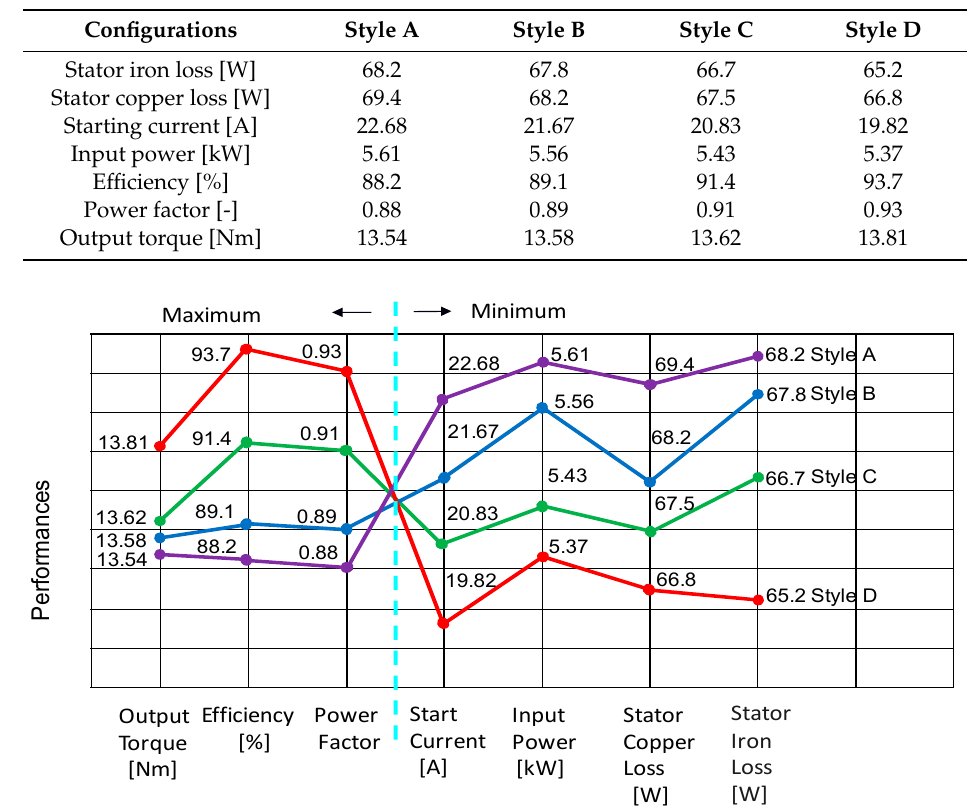
Figure 5. Comparison of several kinds of performances for four kinds of SCSCRIMs.